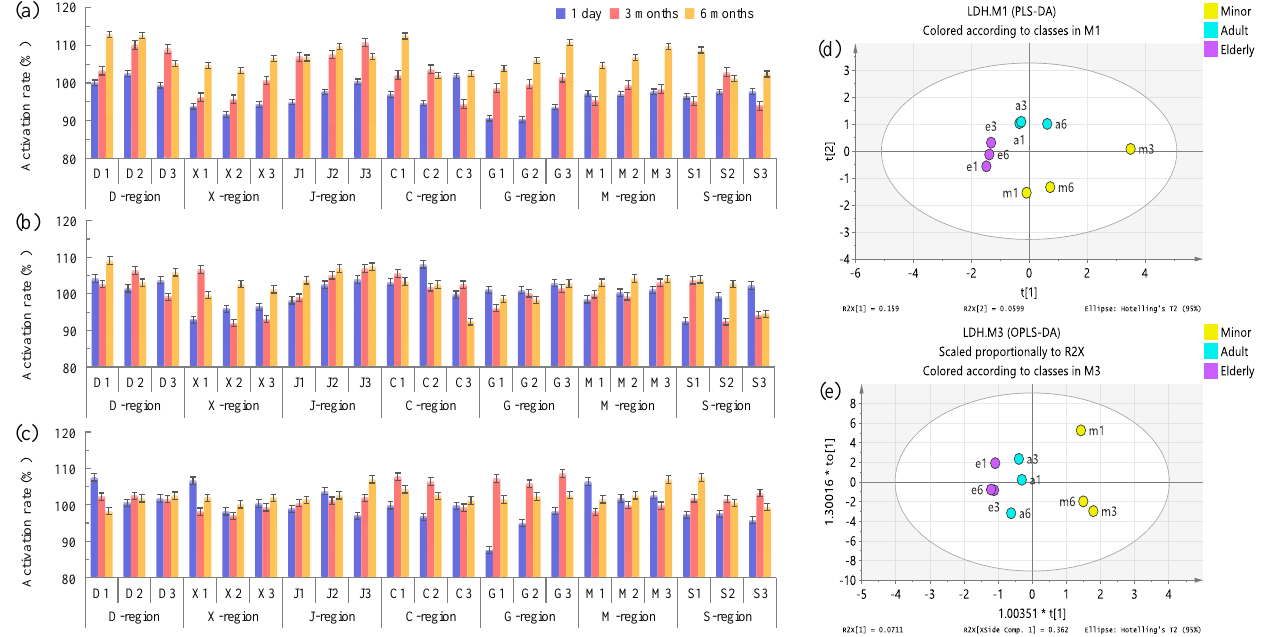
Figure 9. Inhibition rate of COF condensates on LDH of minors ( a ), adults ( b ), and the elderly ( c ), and their PLS-DA ( d ) and OP LS-DA ( e ) diagrams.